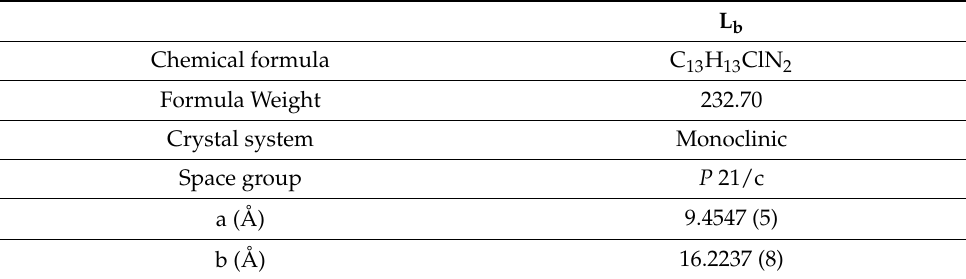
Table 2. Crystal data and structure refinement for L b